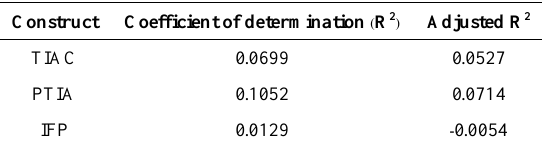
Table 2. Coefficient of determination